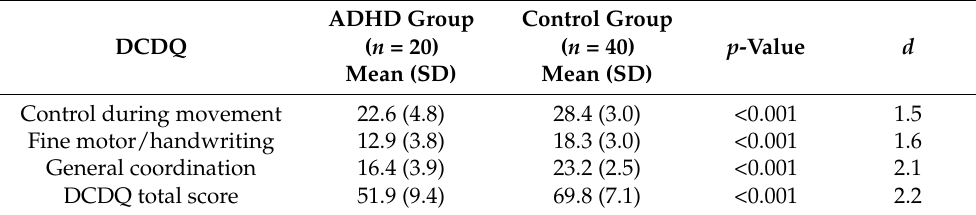
Table 2. Differences in DCDQ subscales and total scores between ADHD and control groups ( n = 60).